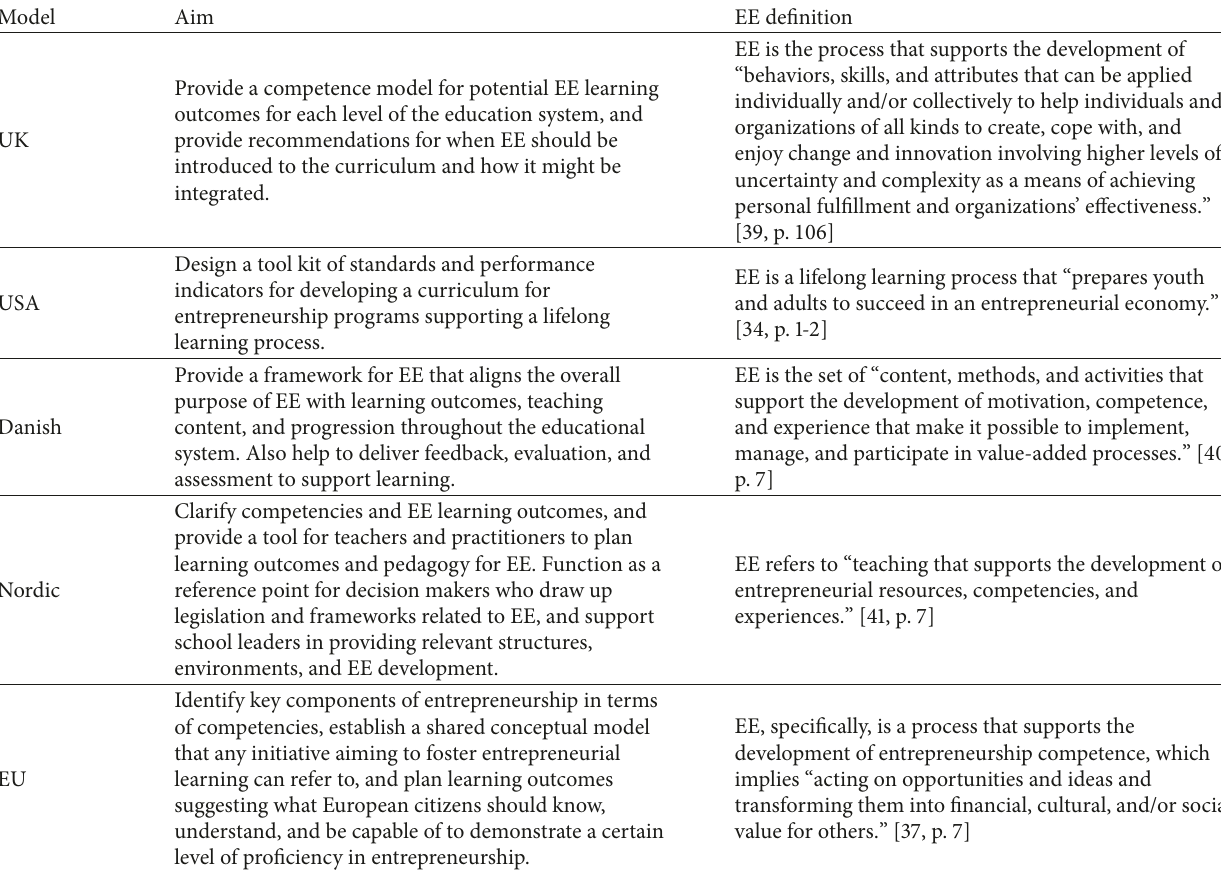
Table 1: Description of the aims and definitions of the chosen EE competence